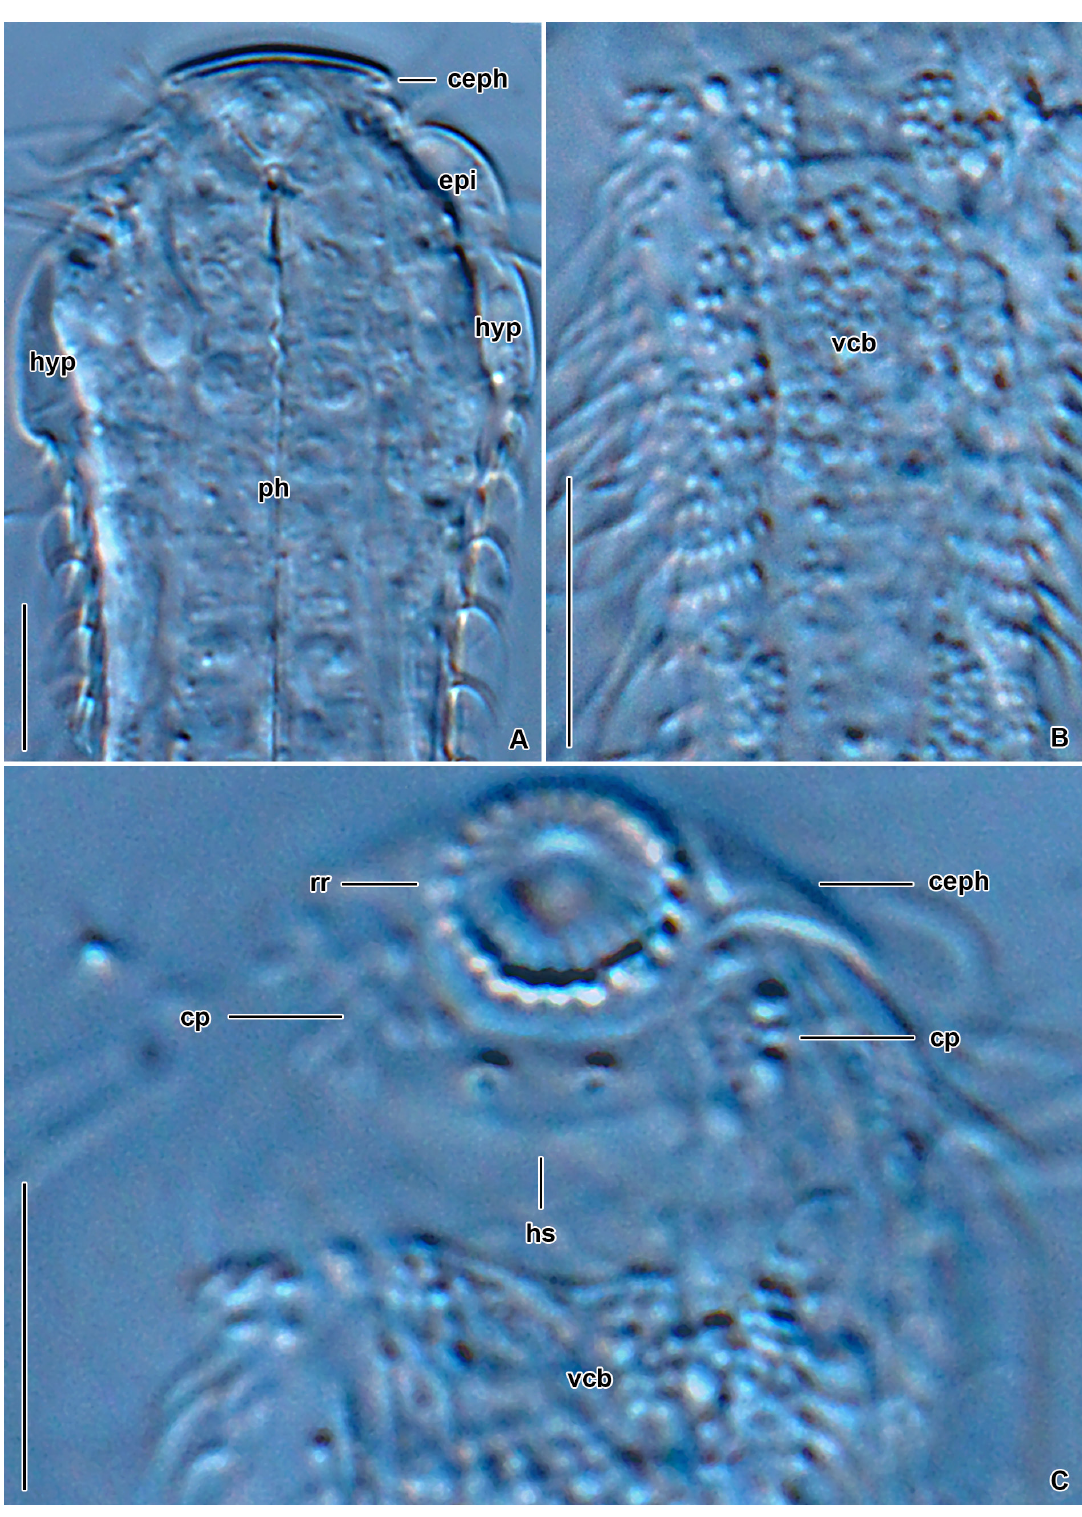
Fig. 26. Chaetonotus ( Hystricochaetonotus ) avarus sp. nov., paratype (CU-FNS-26-02-20/PA-2), differential interference contrast. A . Anterior body region. B . Anteriorly merged ventral ciliary bands. C . Detail of the mouth region. Hypostomium bears a pentagonal cuticular plate with two central protuberances. Scale bars = 10